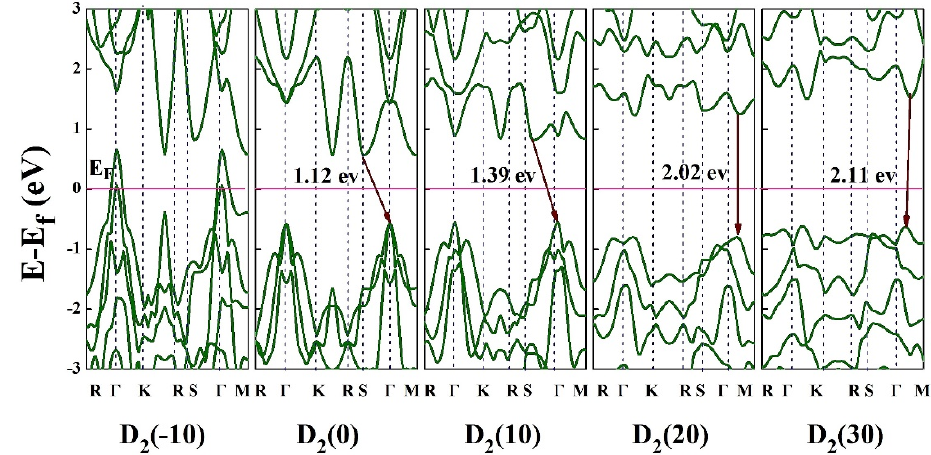
Figure 8. Electronic band structure of HfS 2 monolayer under the uniaxial strains in the range of − 10% to 30% along y direction. The Fermis level is set to zero.